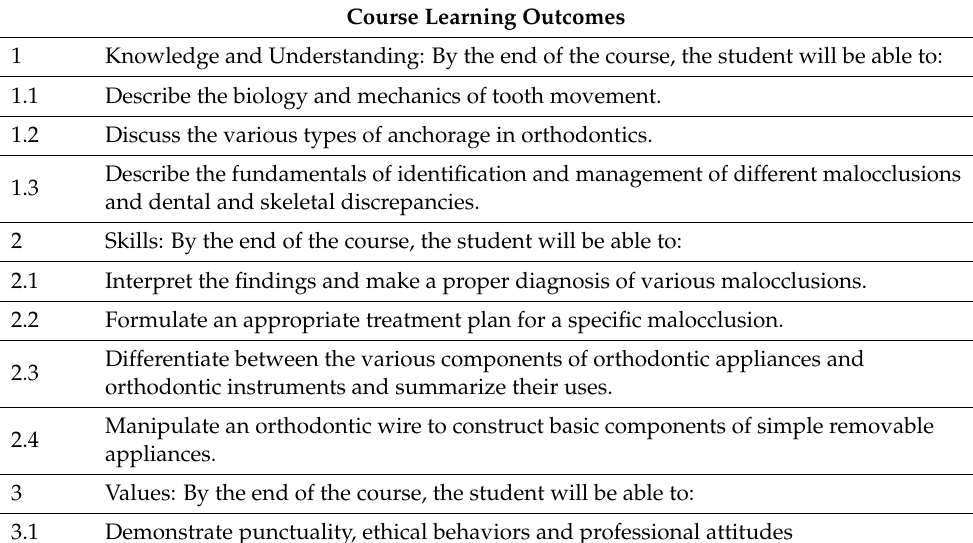
Table 1. Clinical orthodontic I course learning